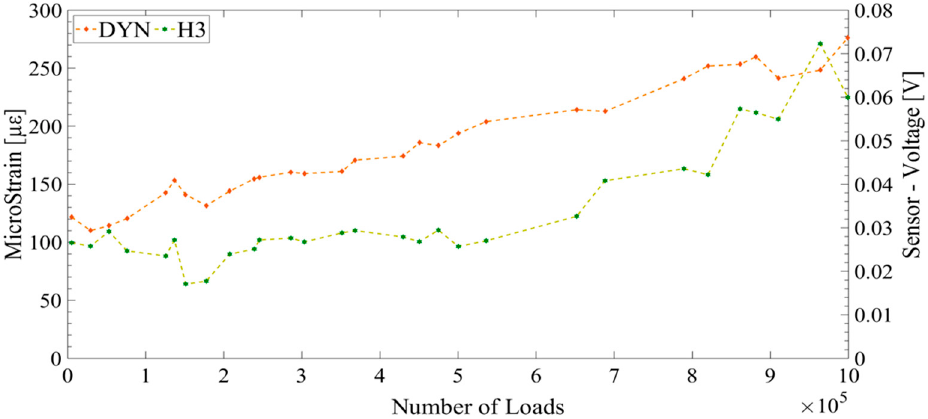
Figure 8. Comparison of strain (DYN) and sensor voltage (H3) at radius 19.0 m.